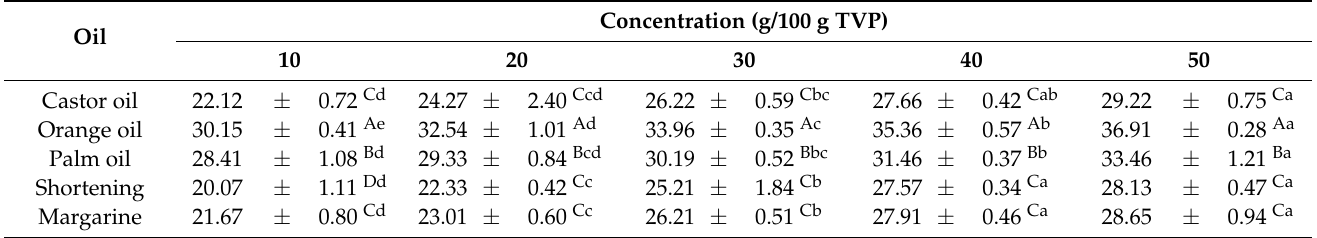
Table 10. DPPH radical scavenging activity (%) of meat analog supplemented with different types or amounts of vegetable oils.